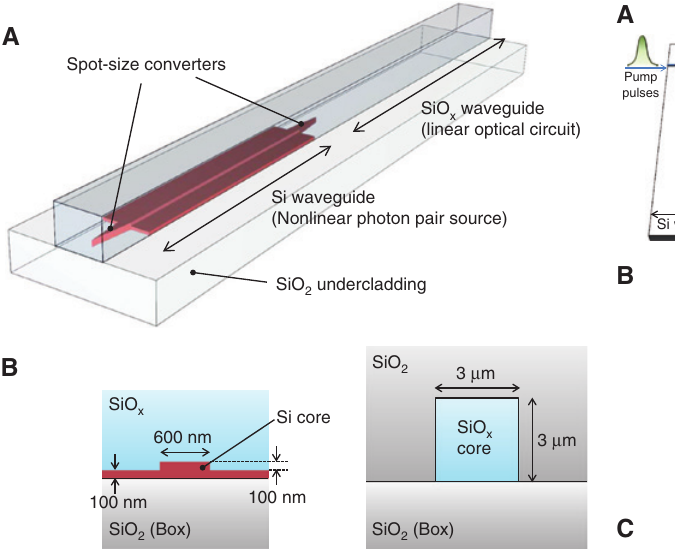
Figure 12: (A) Silicon-silica monolithic waveguide platform for integrating photonic quantum information devices. The silica overcladding and silicon substrate are not displayed for clarity. (B) Cross-sectional views of each waveguide section [116].